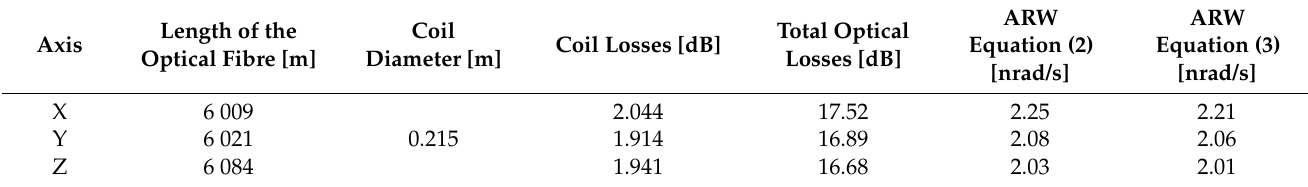
Table 2. Theoretical ARW for the particular constructed optical part comprising the